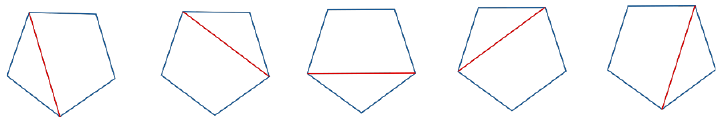
Figure 3 . Partial triangulations of a